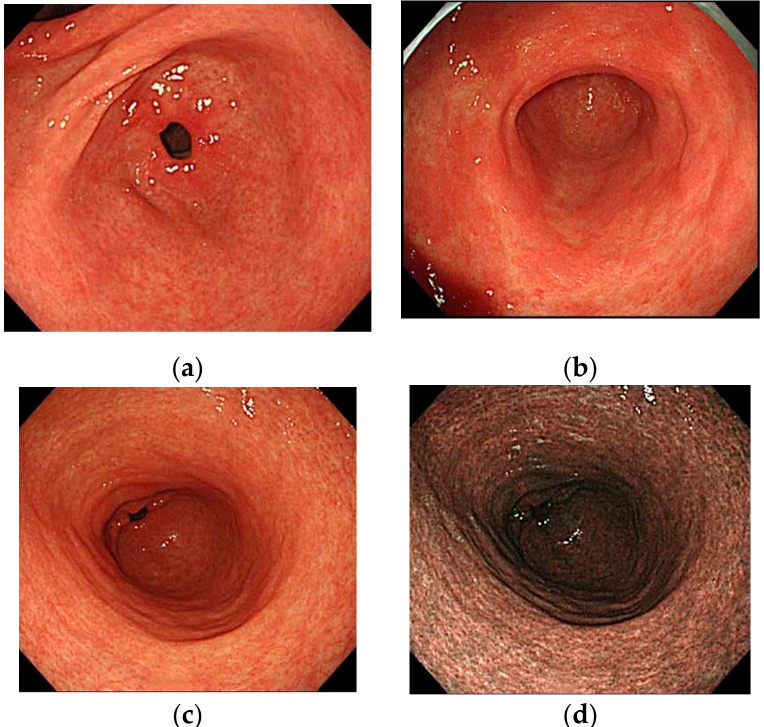
Figure 6. Images of antral mucosa with AIG: ( a ) normal mucosa; ( b ) patchy redness; ( c , d ) circular wrinkle ‐ like pattern (white light image/NBI image).